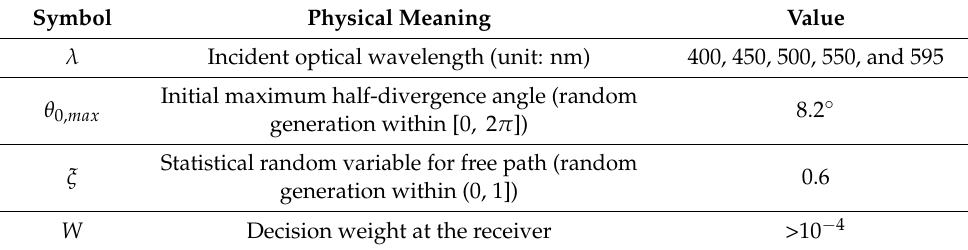
Table 2. Simulation